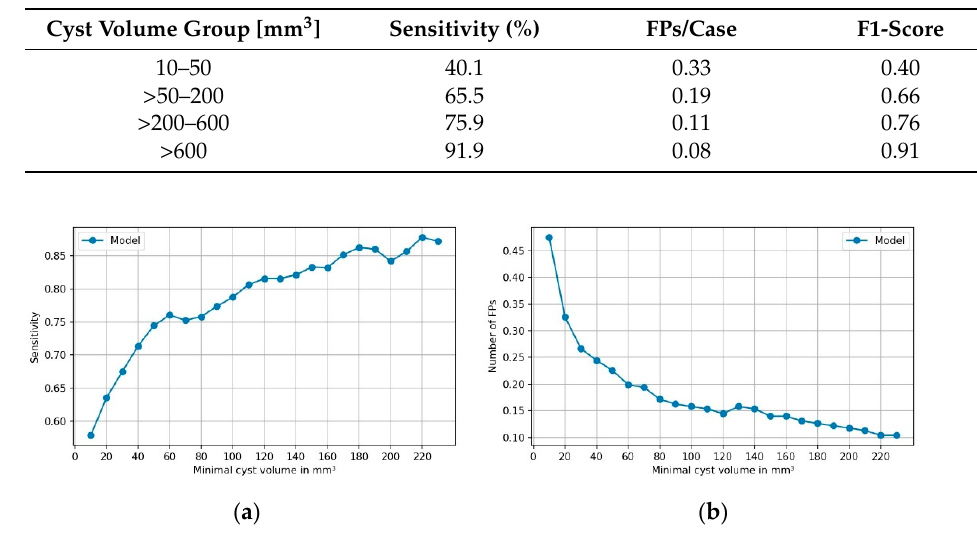
Table 2. Sensitivity, FPs/Case and F1-score of the model regarding detection of PCLs as a function of volume groups of PCLs.